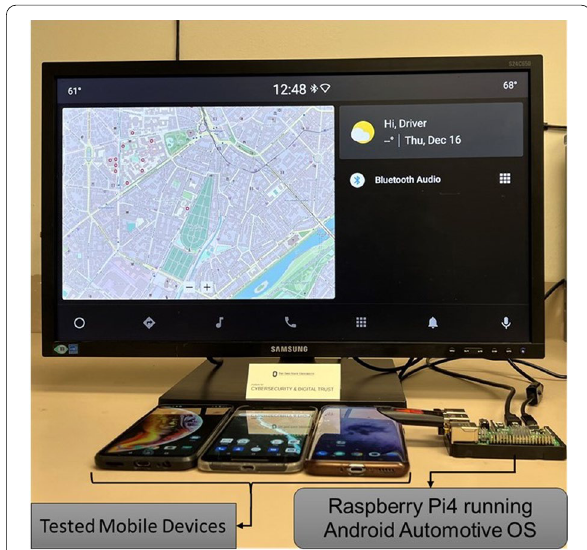
Fig. 7 Experimental Setup mimicking the Android IVI unit on a raspberry Pi4 and three tested mobile devices for privacy